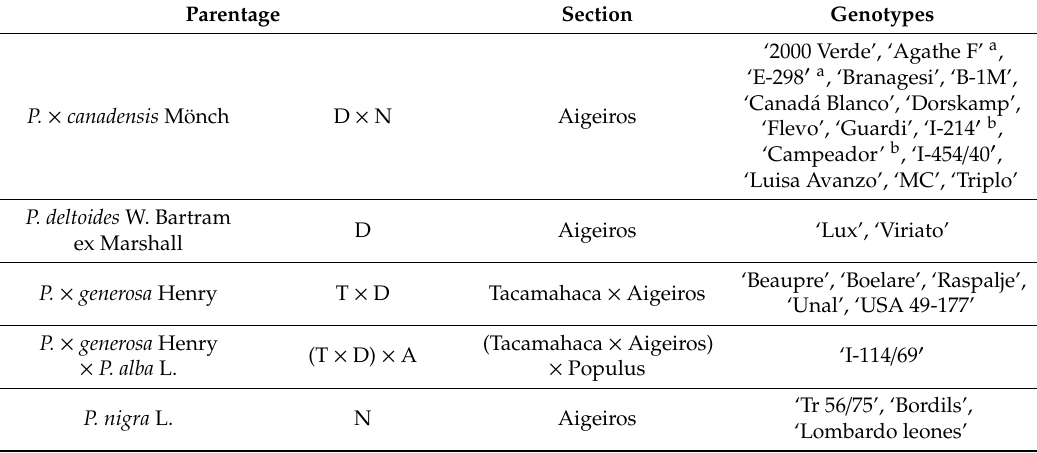
Table 1. Genotypes included in the National Catalogue of Base Materials for the production of forest reproductive materials related to the genus Populus